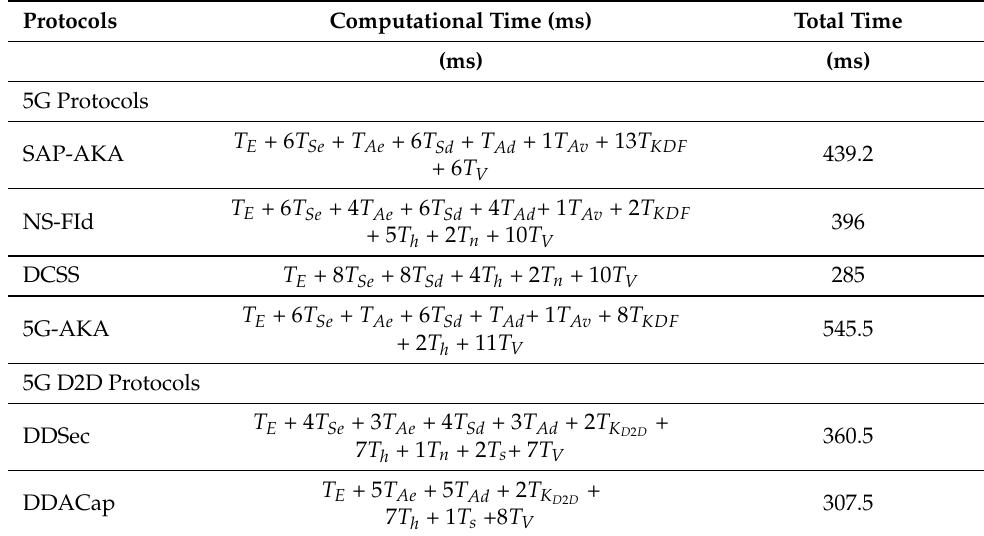
Table 8. Computational Cost of the